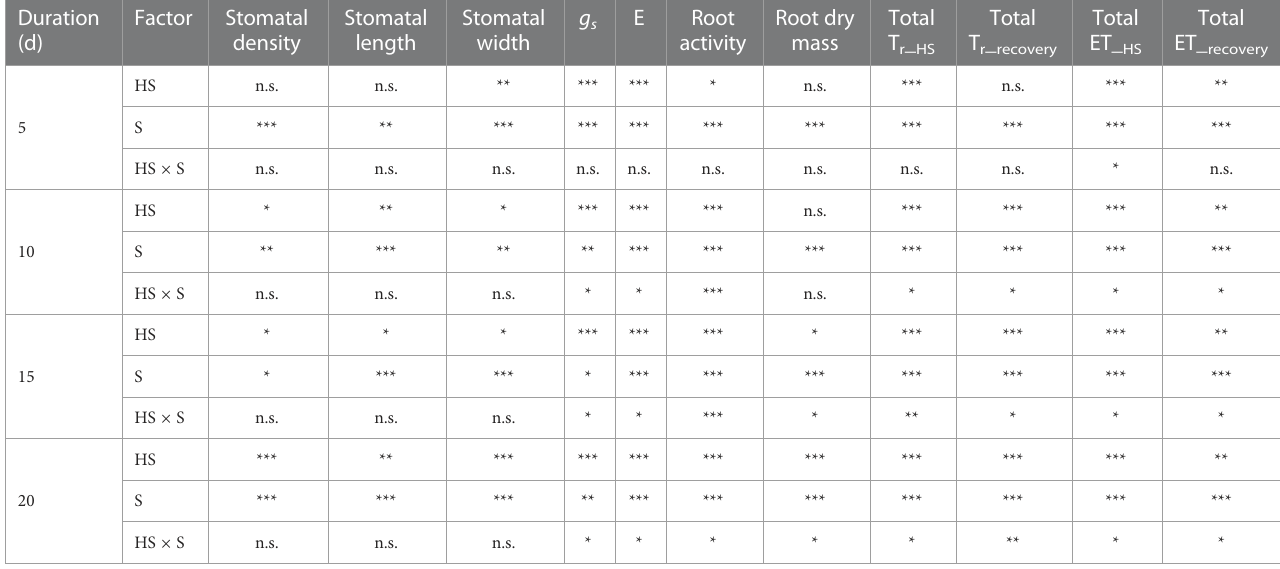
n.s., *, **,*** indicate non-signi fi cance and signi fi cance at P ≤ 0.05, 0.01 or 0.001, respectively.